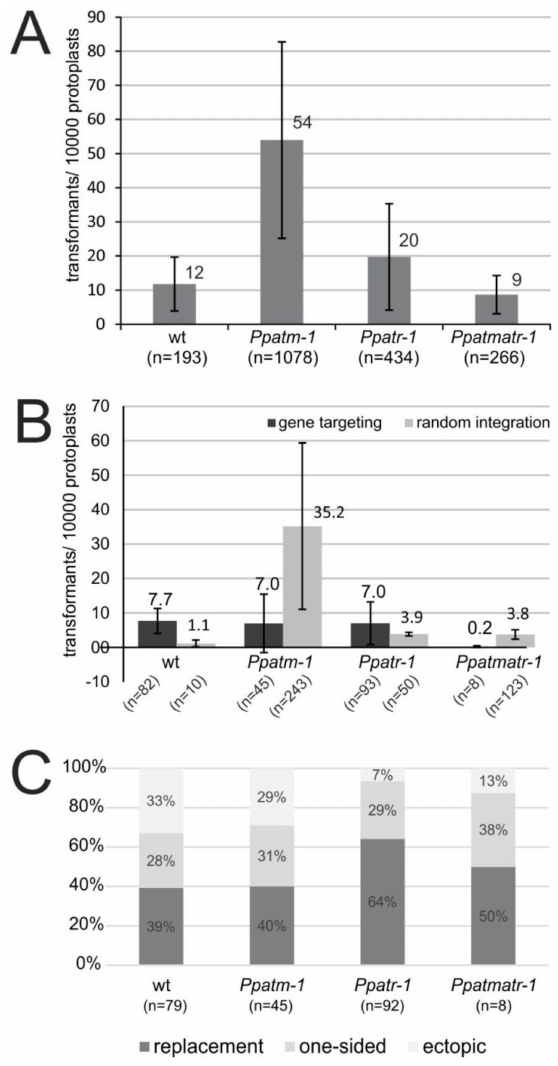
Figure 4. Gene targeting assays. ( A ) The graph shows the number of stable transformants normalized to transformants per 10,000 regenerating protoplasts. The data are the mean of seven independent experiments +/ - SD. ( B ) Proportion of gene targeting and random integration events in wild type and the mutants as determined by 5 (cid:48) and 3 (cid:48) recombination junction-specific PCR in a representative subset of transformants. The data are the mean +/ - SD. ( C ) Relative proportions of gene replacement, one-sided integration, and ectopic targeting in wild type and the mutants, as determined by